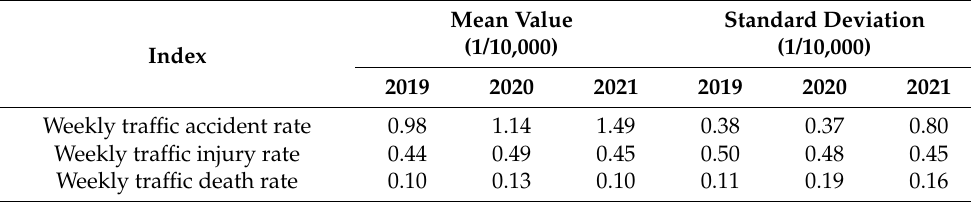
Table 8. The descriptive statistical results of the NPTHN accident rate and casualty